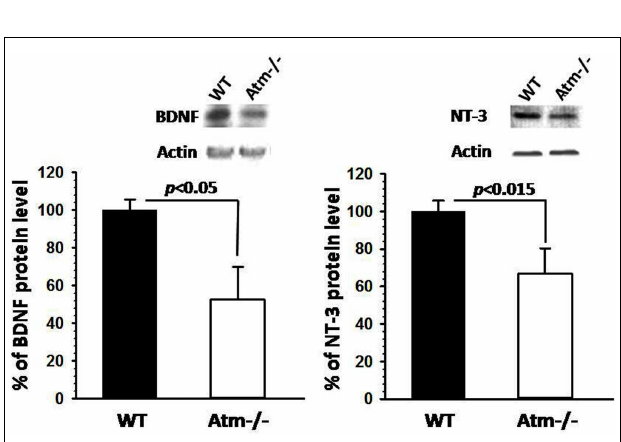
FIGURE 1 | Glial cell alterations in primary cultures derived from Atm − / − mice. M Immunocytochemical stainingof Glial Fibrillary Acidic Protein (GFAP), a marker of astrocytes (green), and Neuronal Nuclei marker